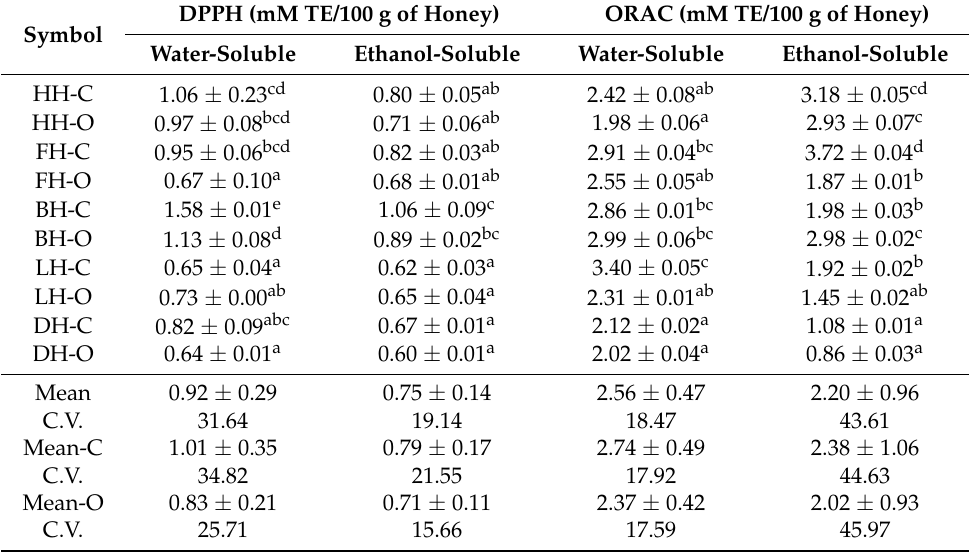
Table 5. Antioxidant activity of water- and ethanol-soluble compounds in honey samples (mean value and standard